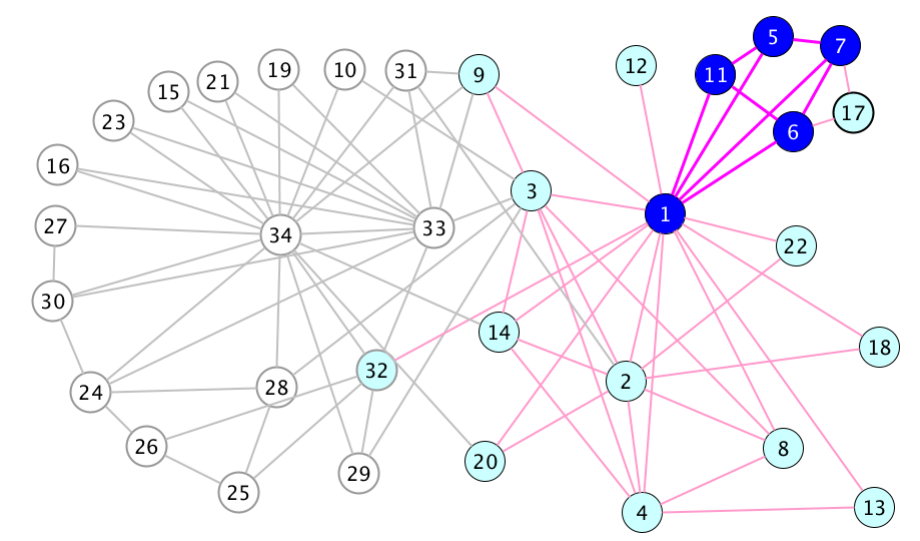
Figure 7. The Karate network, In dark blue the nodes belongging to the maximal 0.5 − quasi-clique for nodes 5, 6, 7, and 11. In light blue the nodes of the first and seconde neighborhood graph that are not members of the optimal community.